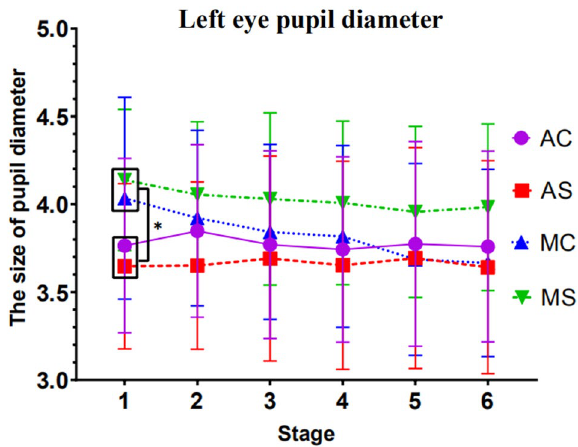
Figure 4. Trend in pupil diameter in the left eye (Note: Vertical bars represent standard errors, * p <